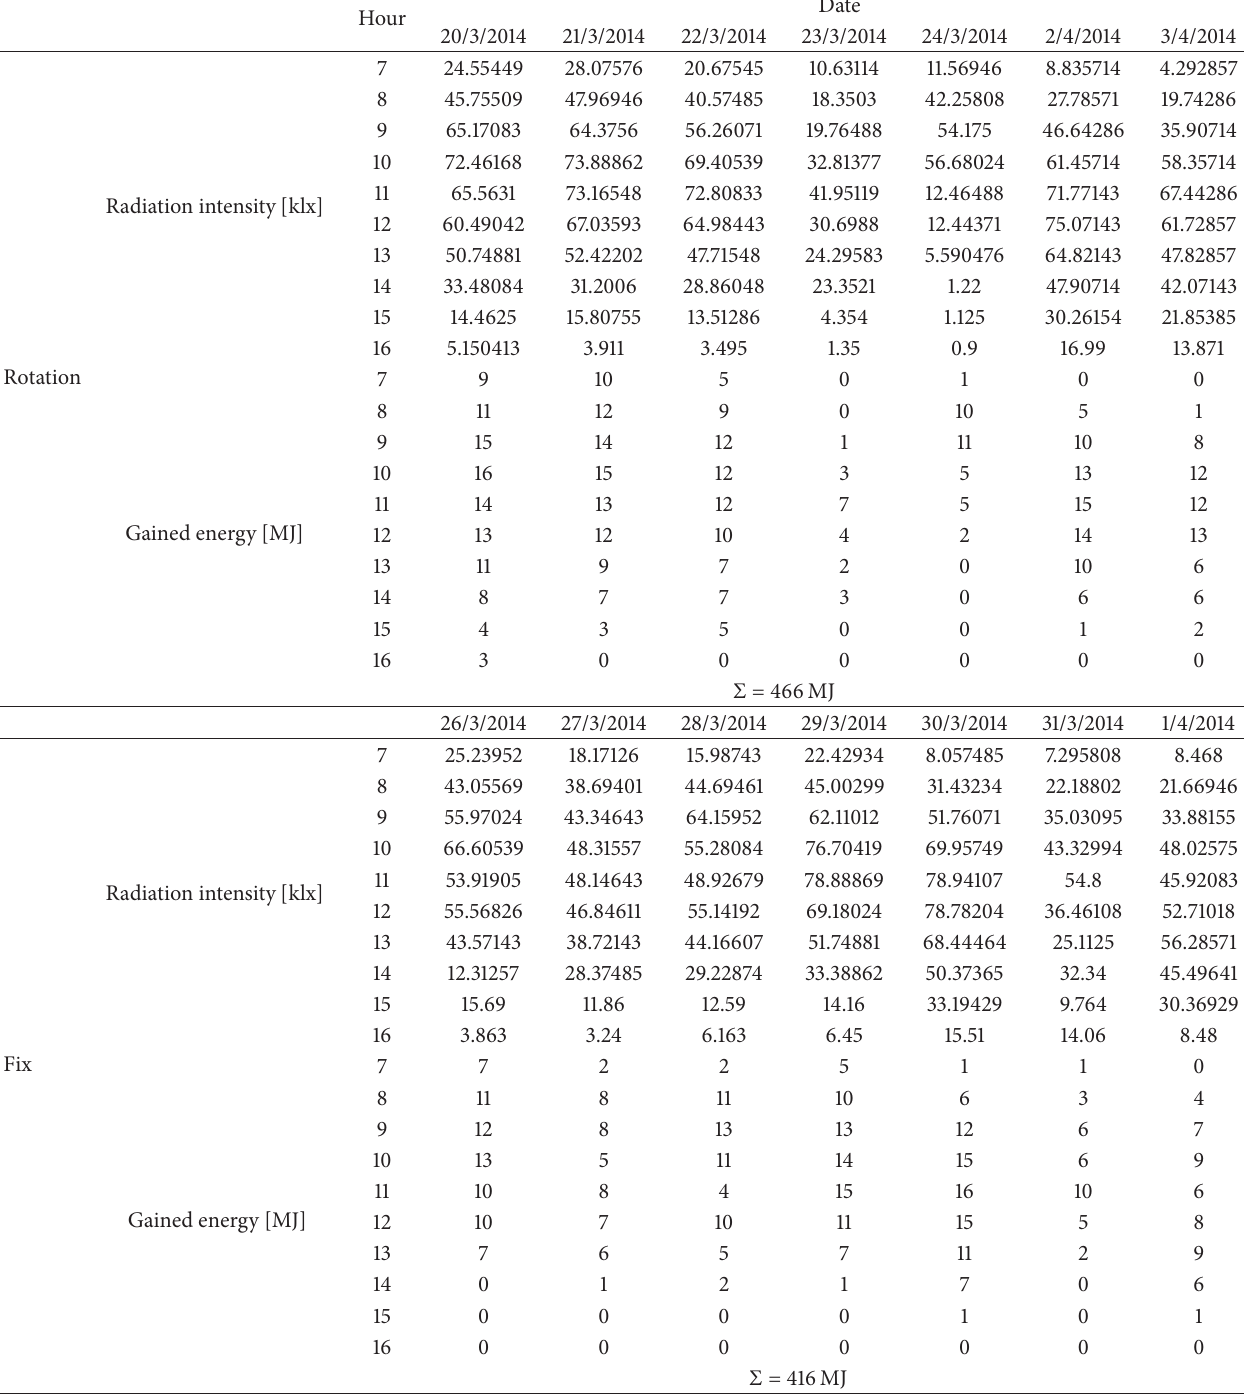
Table 2: The measured values of the solar radiation intensity and the amount of the gained energy.